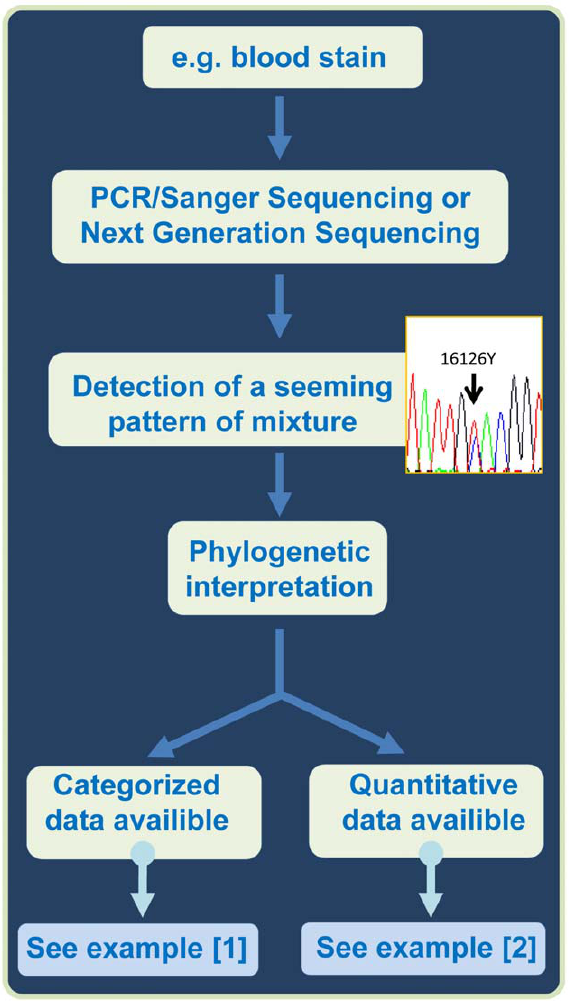
Figure 5. Flowchart of the procedures dealt with in the present